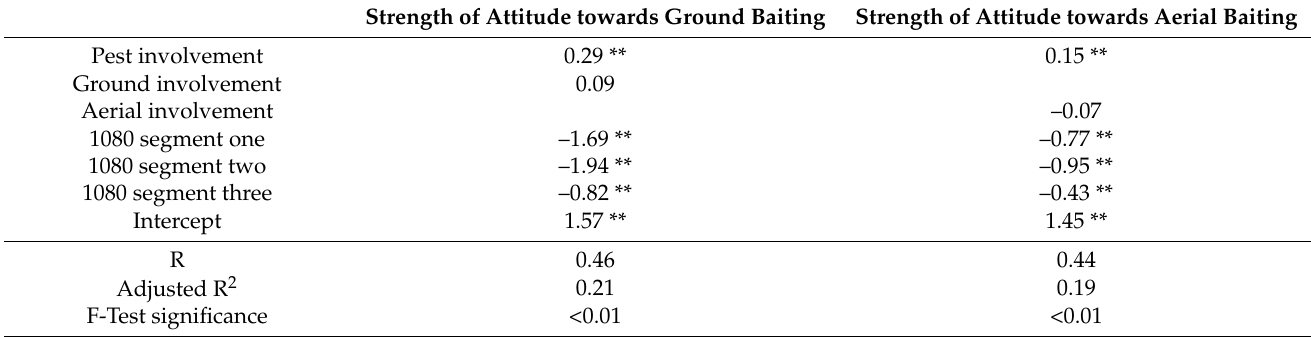
Table 8. Parameter estimates for strength of attitude towards ground and aerial